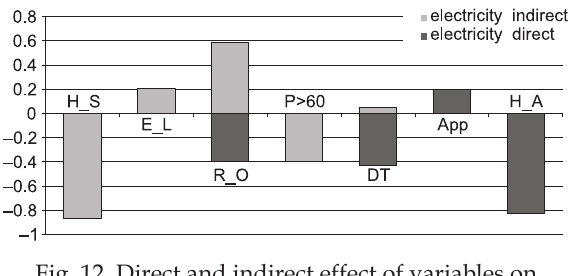
fig. 12. Direct and indirect effect of variables on